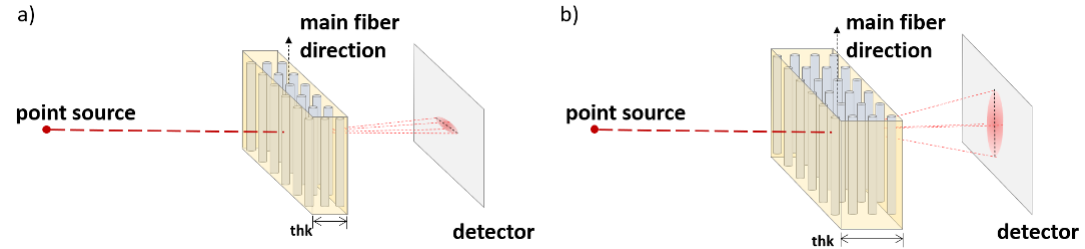
Figure 1. Schematic of ( a ) Fraunhofer Scattering (FS) diffraction and ( b ) Multiple Scattering (MS) physical